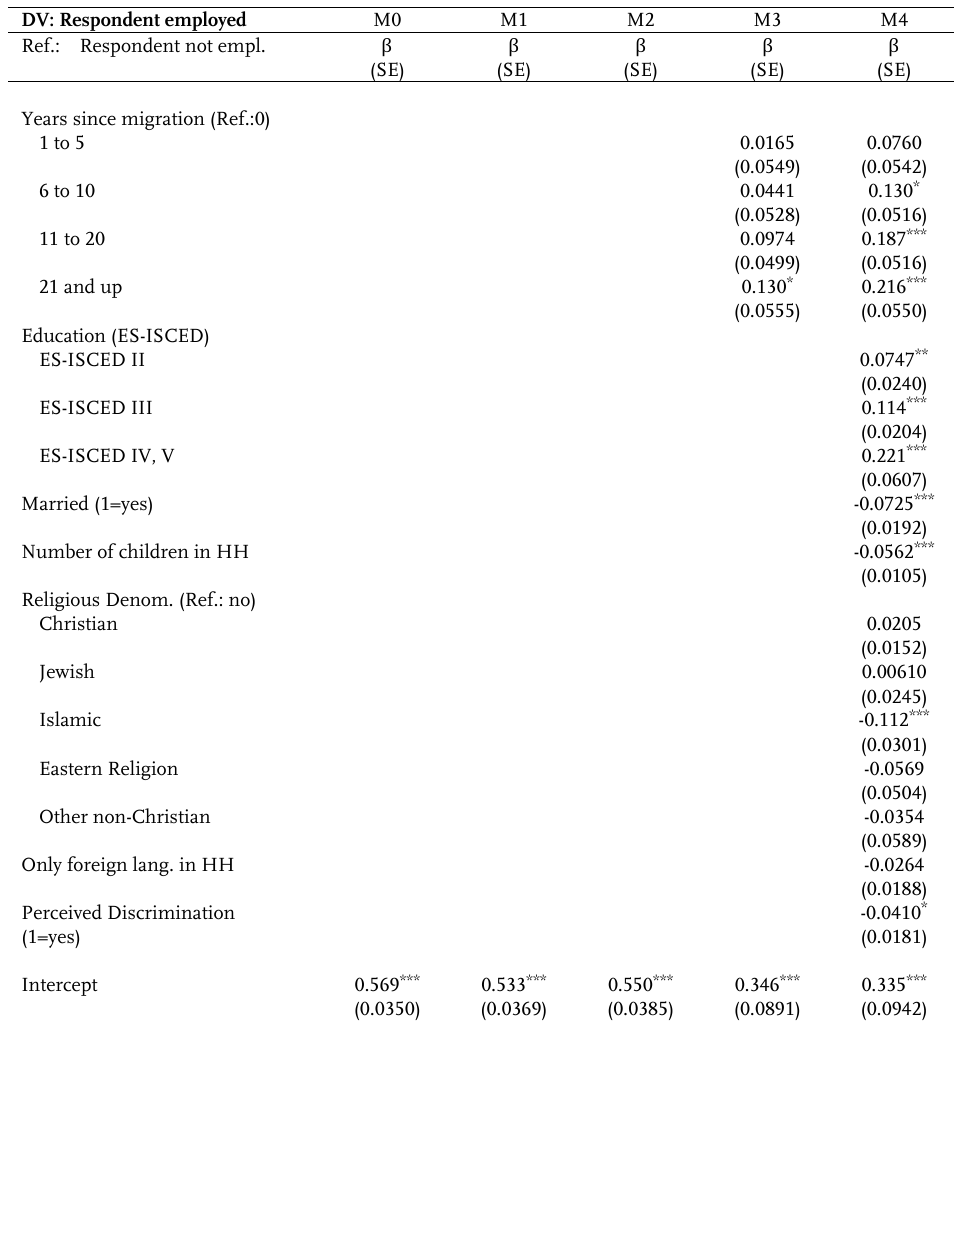
Table A.8 : Linear multilevel probability models for female immigrants’ employment (M1, M2 &